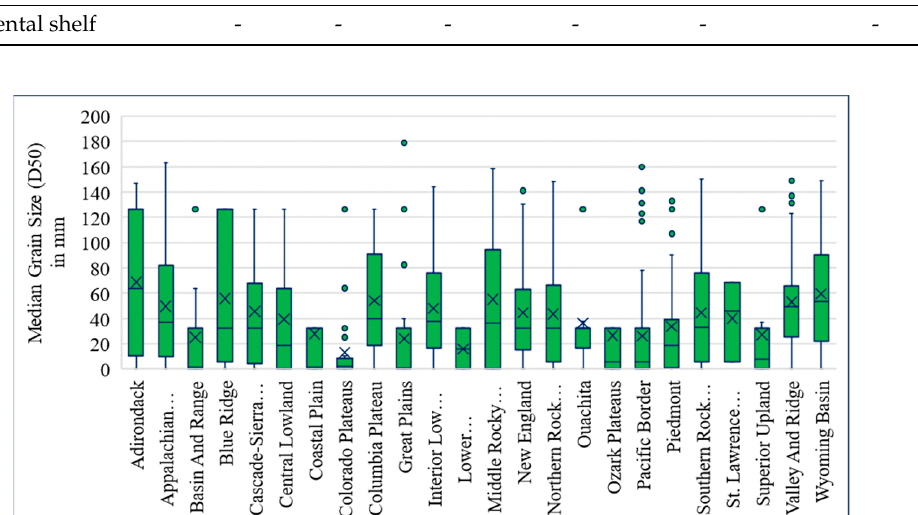
Figure 6. Distribution of D50 data points over Physiographic Provinces.